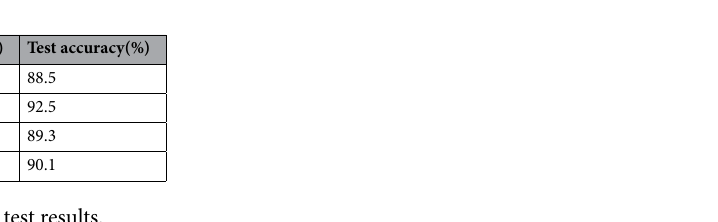
Table 8. Model applicability test